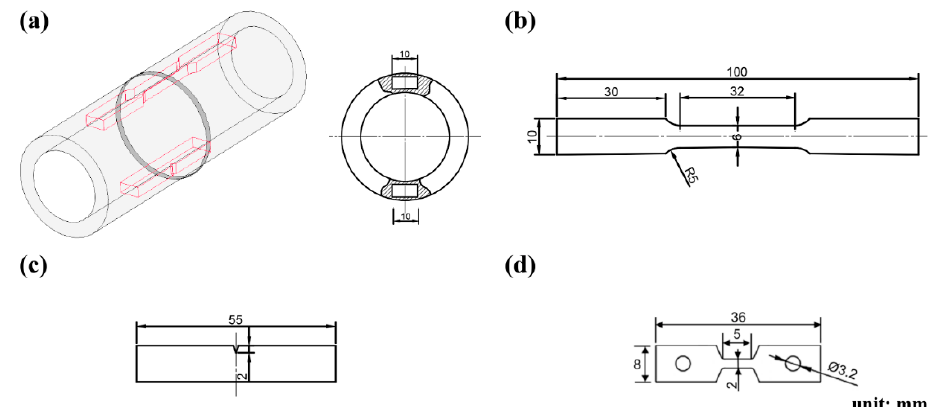
Figure 1. ( a ) The butt ‐ welded groove weld; the dimensions of the ( b ) tensile, ( c ) Charpy V ‐ notch and ( d ) creep samples cut from the finished weld. ( d ) creep samples cut from the finished